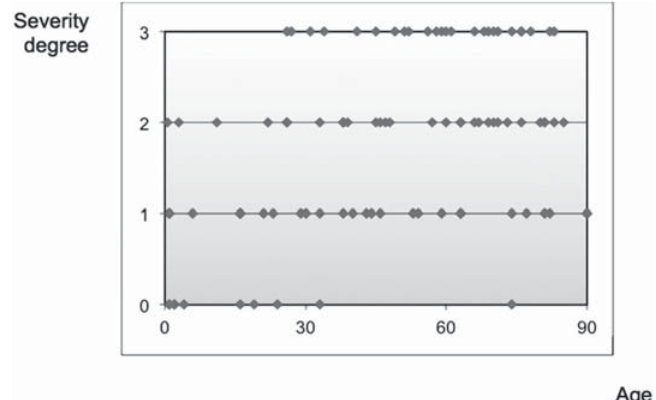
Figure 4- Distribution of the different degrees of acinar autolysis according to